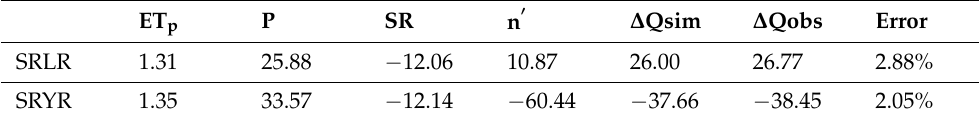
Table 2. Changes in runoff due to changes in factors estimated by Budyko